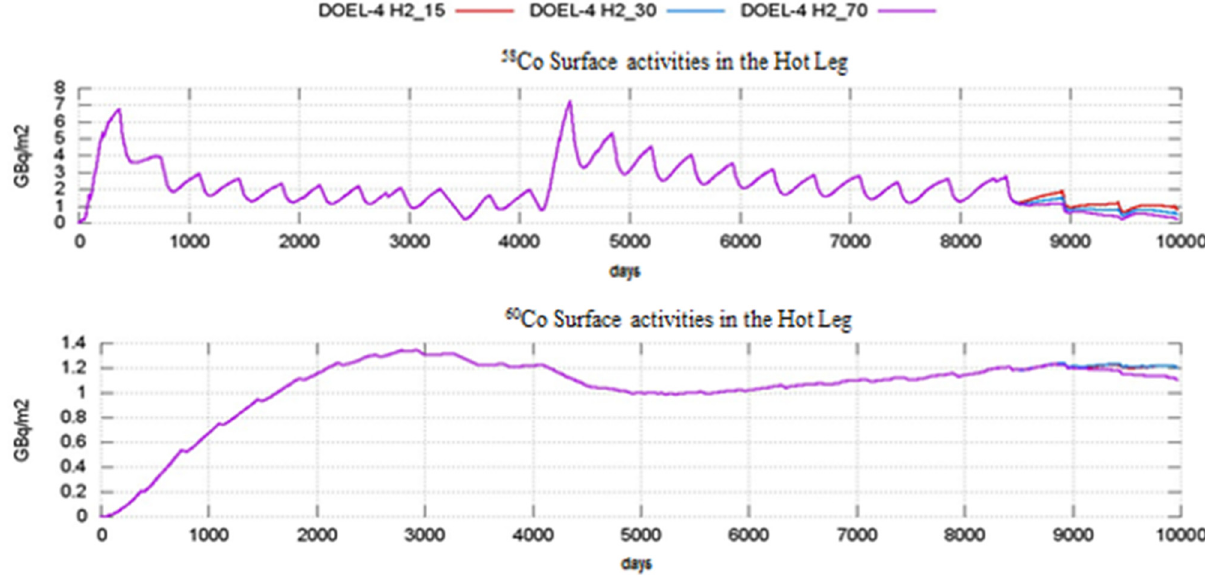
Fig. 4. OSCAR V1.3 calculation (cid:2) Surface activities in the Hot leg region of DOEL-4.